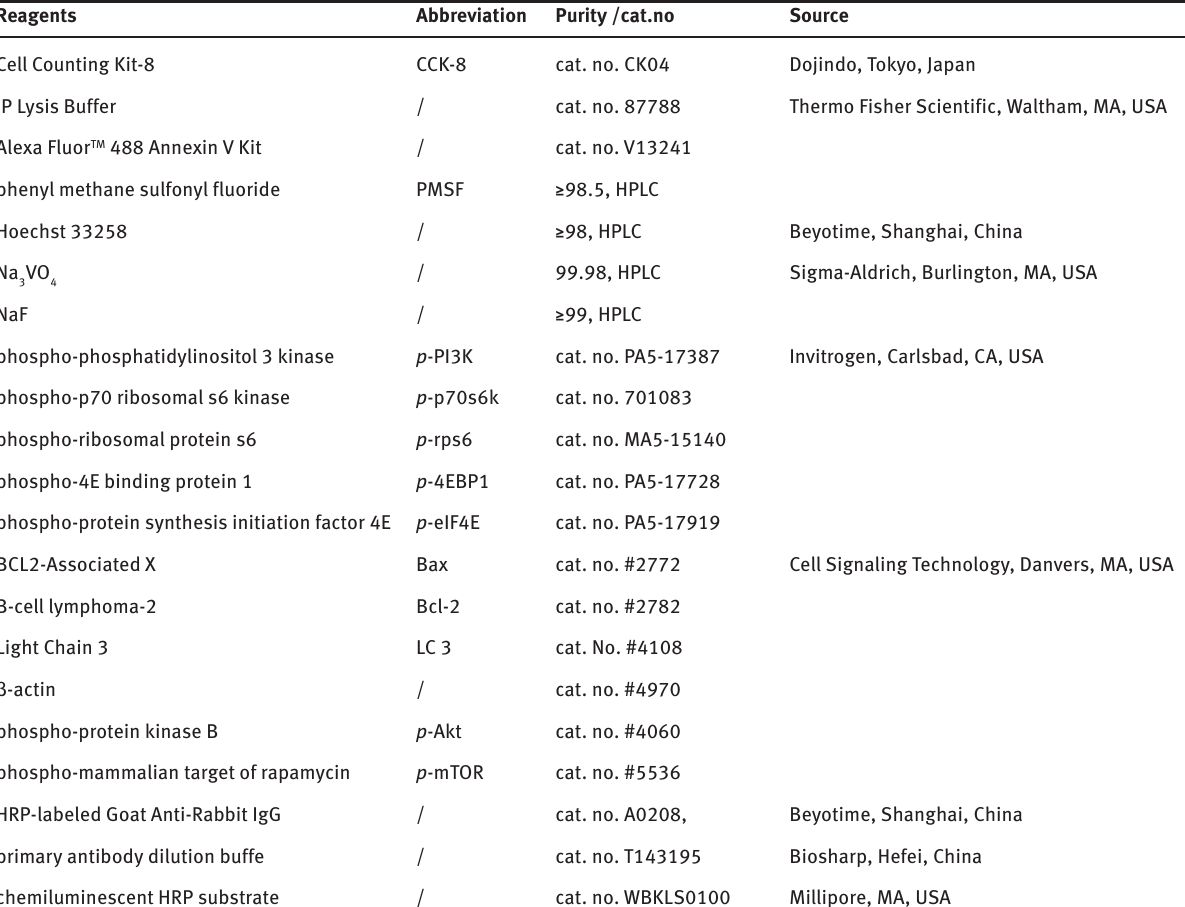
Table 1: Information of the